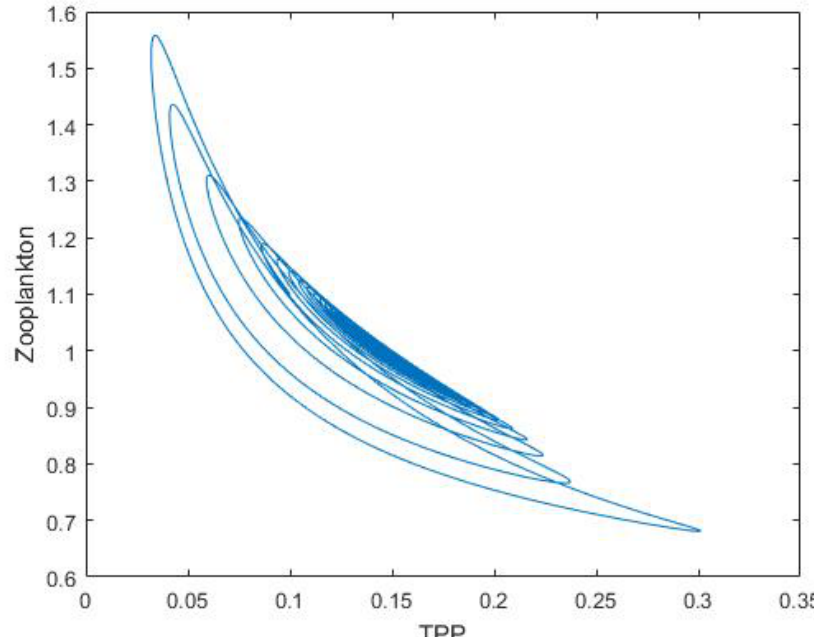
Figure 5. The asymptotical stability of equilibrium the between TPP and zooplankton populations for τ = τ 0 =